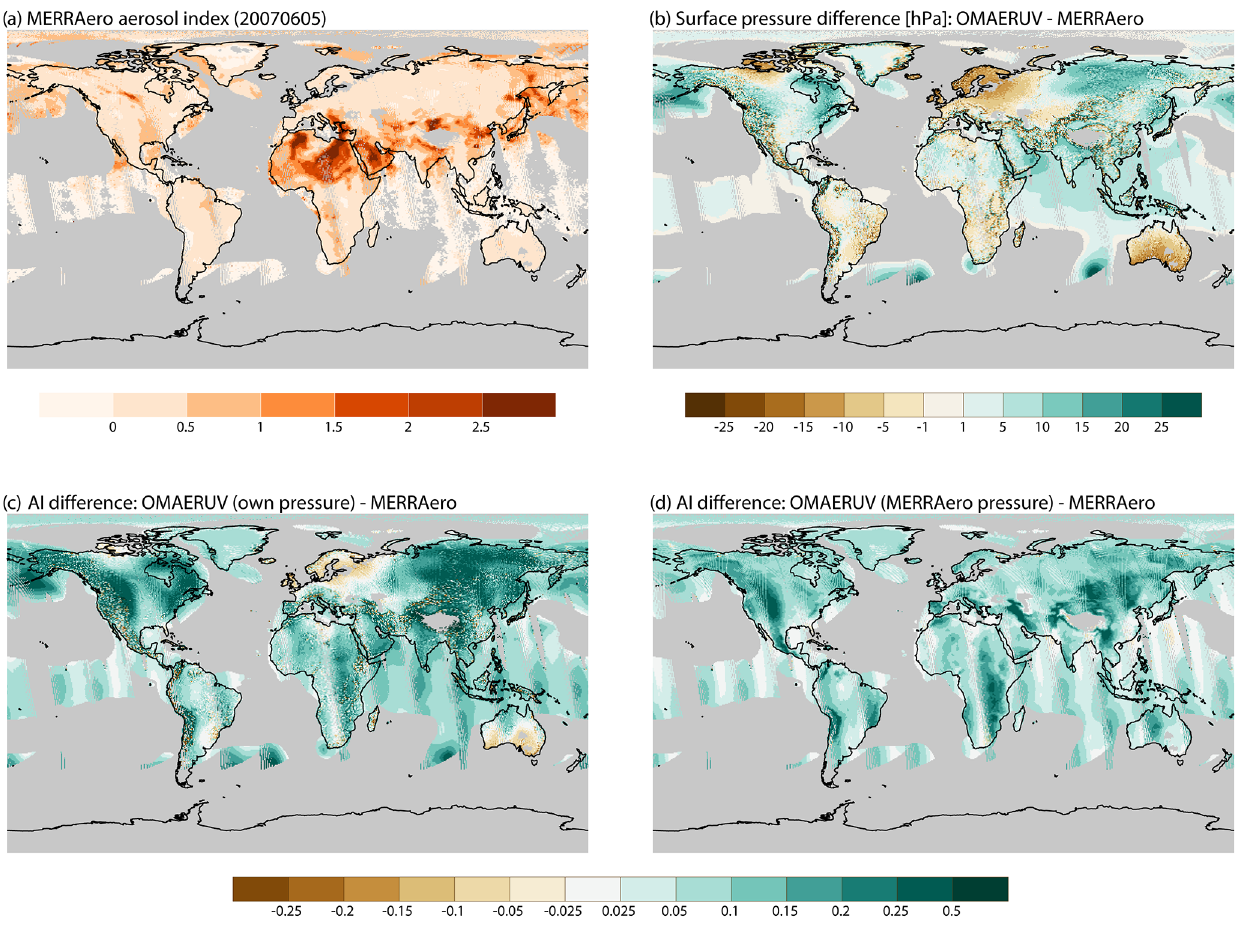
Figure 1. (a) MERRAero simulated aerosol index on 5 June 2007. (b) OMAERUV–MERRAero difference in surface pressure (hPa) for the same day. (c) OMAERUV AI–MERRAero AI difference, with OMAERUV using its own surface pressure. (d) OMAERUV AI–MERRAero AI difference with OMAERUV using the MERRAero provided surface